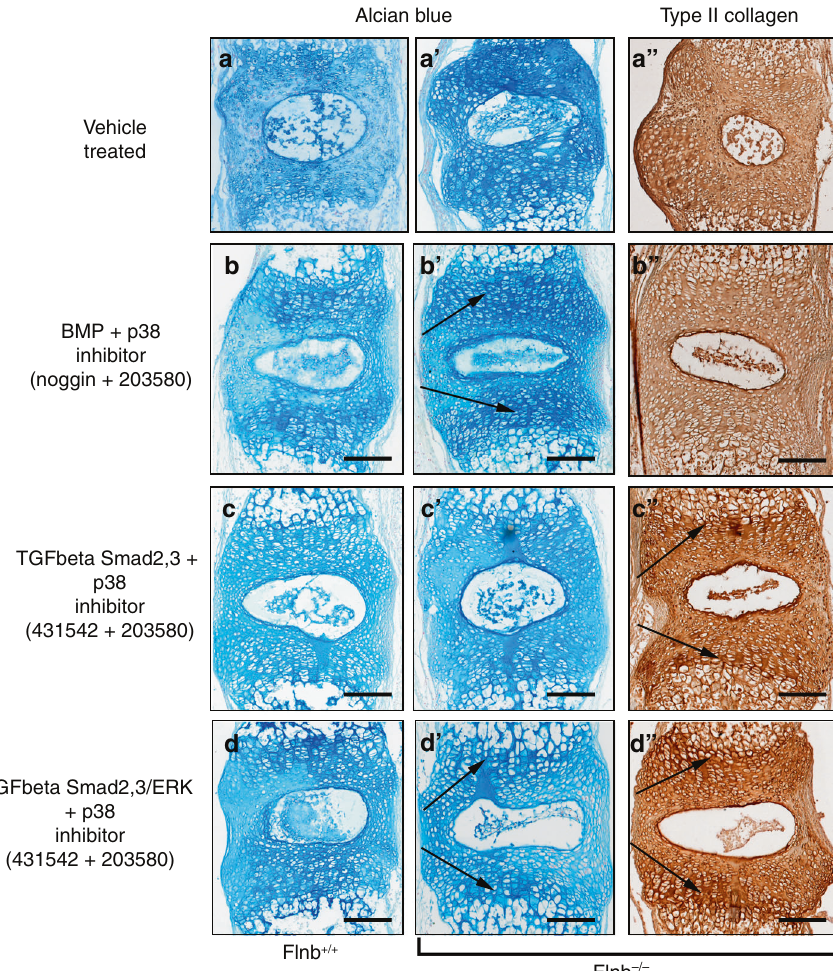
Fig. 6 The Flnb − / − phenotype is rescued by combinatorial inhibition of TGF β and p38 signaling. a – d Representative images of sagittal sections of T7-T8 cultured IVDs stained with Alcian Blue for proteoglycan secretion or IHC-HRP using an antibody against type II collagen. a – a ” Flnb – / – spine exhibiting increased proteoglycan secretion Type II Collagen secretion and disrupted tissue architecture ( b – b ” ) Inhibition of BMP/p38 in combination reduces proteoglycan secretion in the AF while maintaining higher levels in the AC of Flnb – / – IVDs and shows improvement of Type II Collagen levels but not distribution (black arrows). c – c ” ) Inhibition of TGF β /Smad2,3/p38 improved proteoglycan levels but not distribution while reducing type II collagen secretion in the AF and maintaining higher levels in the AC of Flnb – / – IVDs (black arrows). d – d ” Inhibition of TGF β / Smad2,3/ERK/p38 in combination reduces proteoglycan secretion, and type II collagen in the AF maintains higher levels in the AC of Flnb – / – IVDs (black arrows) while also rescuing tissue architecture. n = 3 individual mouse spines with multiple affected rescue of proteoglycan and type II collagen levels or tissue architecture and are reported in Fig. S2. The inhibition of the BMP pathway (via Noggin) and p38 activation (via SB 203580) reduced proteoglycan secretion/distribution and repaired tissue architecture (Fig. 6b, b ’ , b ” ) when compared to vehicle treated Flnb – / – spines showing increased proteoglycan secretion and tissue architecture disruption (Fig. 6a ’ , a ” ). This treatment combination, however, only mildly improved type II collagen levels and did not improve type II collagen distribution, indicating that inhibition of BMP at the receptor level does not suf fi ciently rescue the Flnb − / − IVD (Fig. 5f ” ). Cultured Flnb − / − spines exposed to TGF β /Smad 2/3 (via SB-431542) and p38 inhibitors exhibited repaired disc architecture, improved type II collagen levels/distribution, and lowered proteoglycan levels but did not improve proteoglycan distribution when compared to untreated Flnb − / − spines (Fig. 6c, c ’ , c ” ). Ultimately, based on improved cellular appearance and reduced proteoglycan and type II collagen expression, TGF β /Smad 2/3, ERK and p38 inhibition was found to be most effective in rescuing the Flnb − / − IVD phenotype (Fig. 6d, d ’ , d ” ). These results suggest that